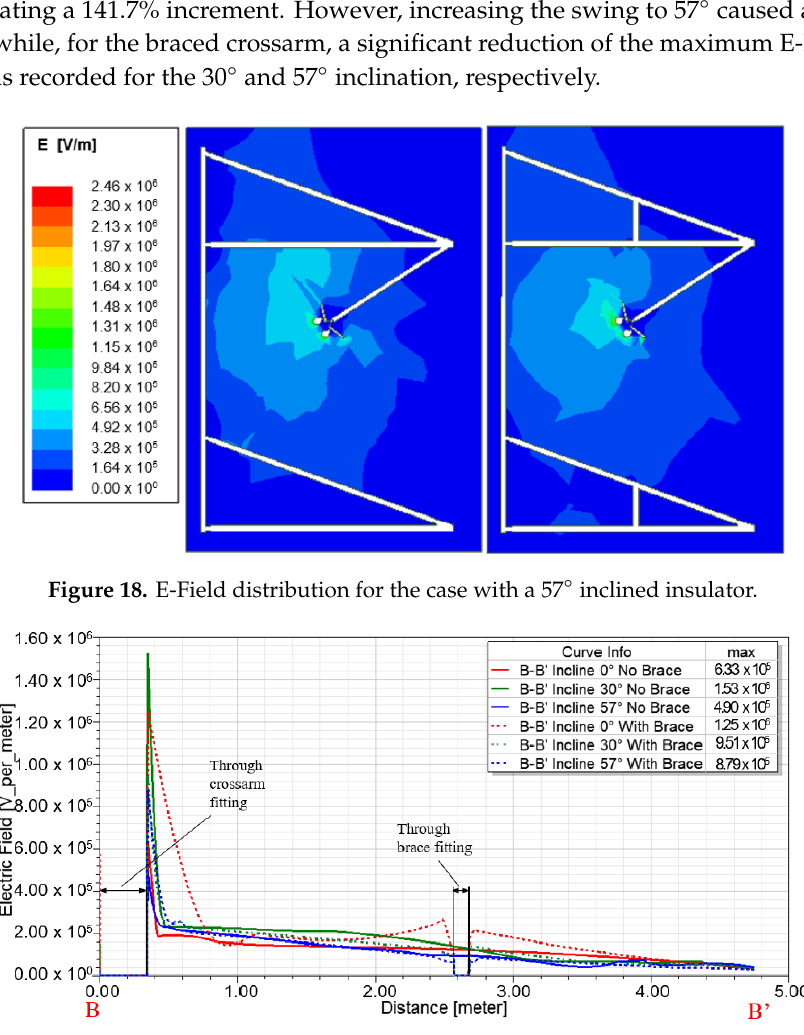
Figure 19. E-Field strength (measured at B–B’) due to di ff erent swing angles.